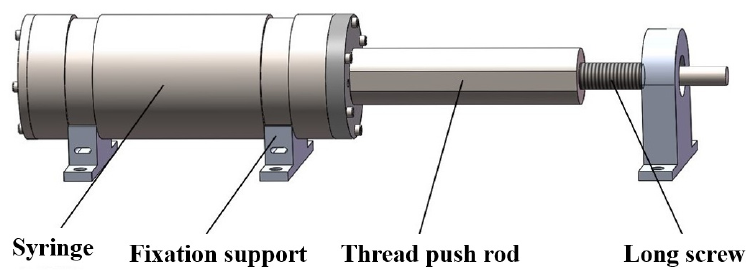
Figure 2. Device schematic diagram of RNAlater preservation solution injector with syringe struc- ture.